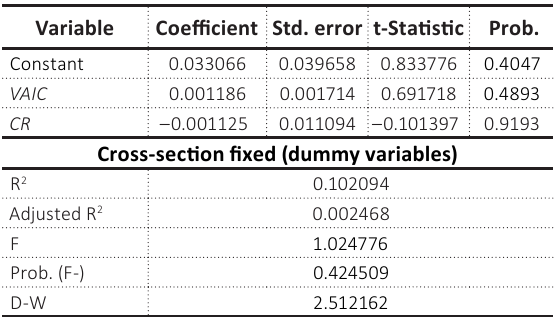
Table 11. Random effects for model 1